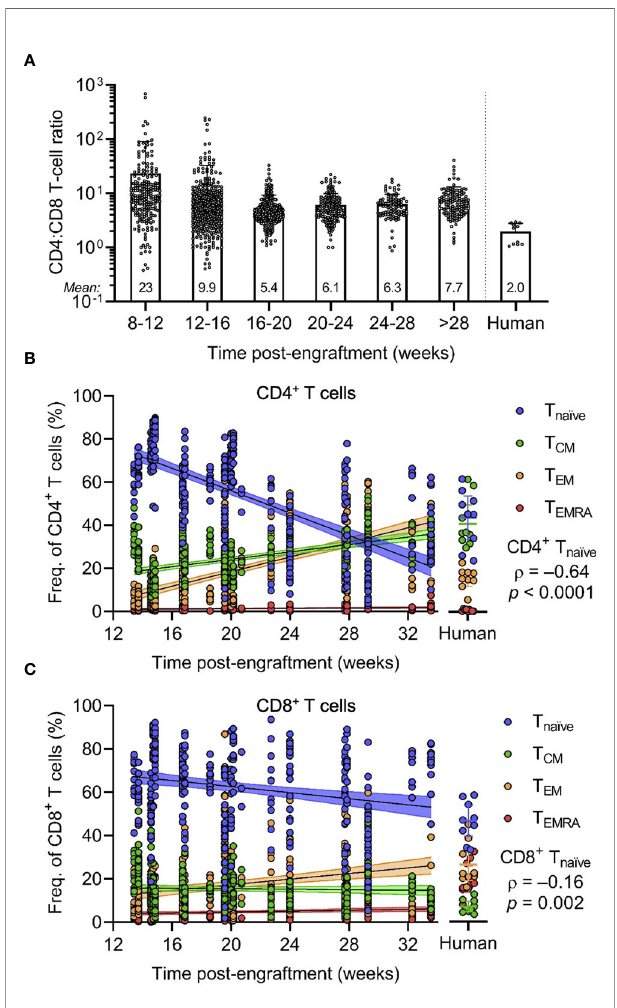
FIGURE 3 | CD4/CD8 T-cell ratios and naïve T cell frequencies are increased in HuBLT mice but change with age. (A) Peripheral blood leukocytes from HuBLT mice ( n = 685 mice from 33 distinct human tissue donors) and healthy adult human donors ( n = 11) were analyzed via fl ow cytometry to assess for CD4:CD8 T-cell ratios at different times post- engraftment. Data was binned at 4-week intervals, with mean CD4:CD8 T- cell ratios for each bin depicted at the bottom of each bin bar; some mice had repeat measurements at multiple time points. (B, C) Peripheral blood leukocytes from HuBLT mice ( n = 329 mice from 17 distinct human tissue donors) and healthy adult human donors ( n = 9) were analyzed via fl ow cytometry to assess for frequencies of naïve (T naïve ; CD45RA + CCR7 + ; blue), central memory (T CM ; CD45RA – CCR7 + ; green), effector memory (T EM ; CD45RA – CCR7 – ; orange), and effector memory re-expressing CD45RA (T EMRA ; CD45RA + CCR7 – ; red) cells within CD4 + T cells (in B ) and CD8 + T cells (in C ) at different times post-engraftment. For (B, C) , linear regression (black line) with 95% con fi dence intervals (colored shade) for each population is depicted for visualization, as well as Spearman coef fi cients ( r ) with corresponding p values for the indicated T naïve (46), CCR4 expression correlates with IL-4 production (T H 2 polarization) (46), and CCR6 expression correlates with IL-17 production (T H 17 polarization) (47). We explored whether these associations held true for T H 1-polarized cells in HuBLT mice to use